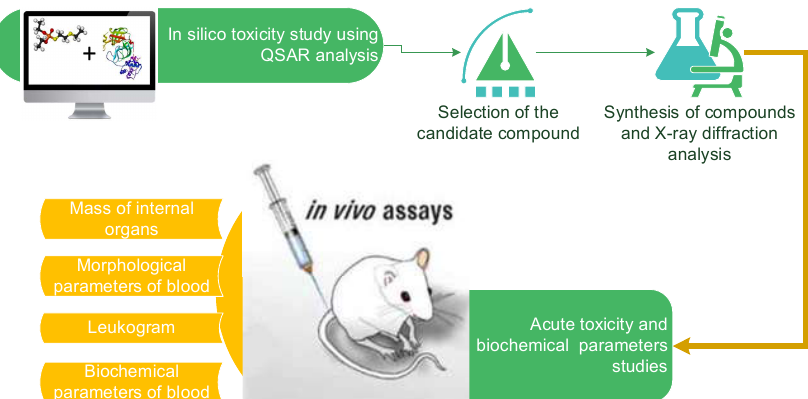
Fig. 1. Block diagram of the study of the parameters of toxicity of